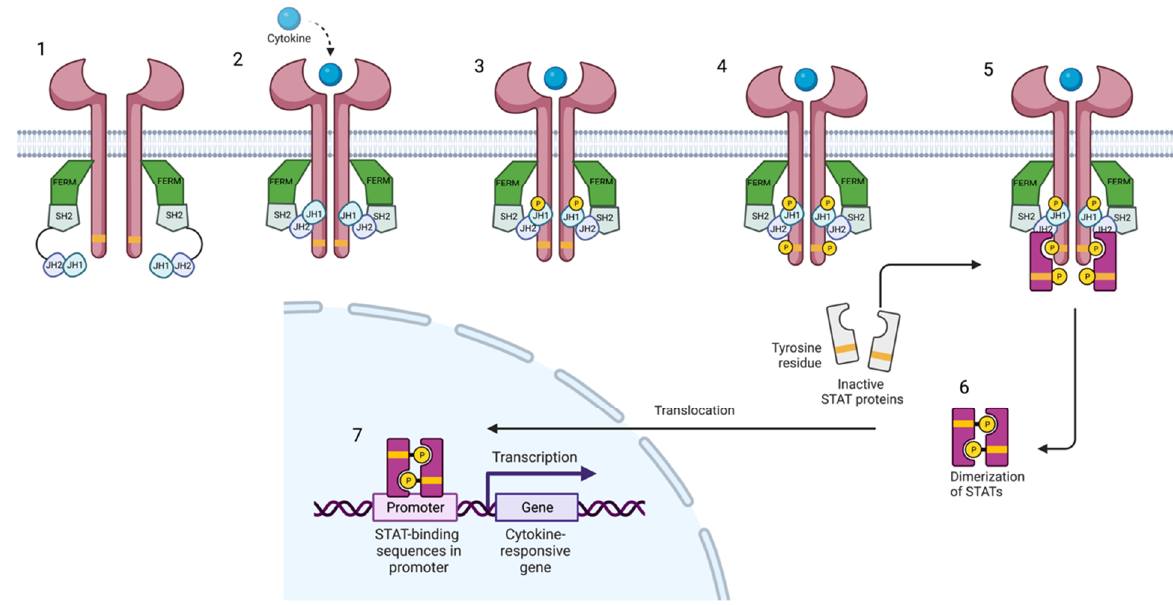
Figure 1. Janus kinase-signal transducer and activator of transcription pathway. Cytokines bind to their receptor, leading to the activation of Jak and their phosphorylation. Subsequently, STAT is phosphorylated and dimerized. Activated STAT dimers translocate to the nucleus and regulate gene transcription and expression. Created with BioRender.com (accessed on 14 January 2023). Abbrevi-